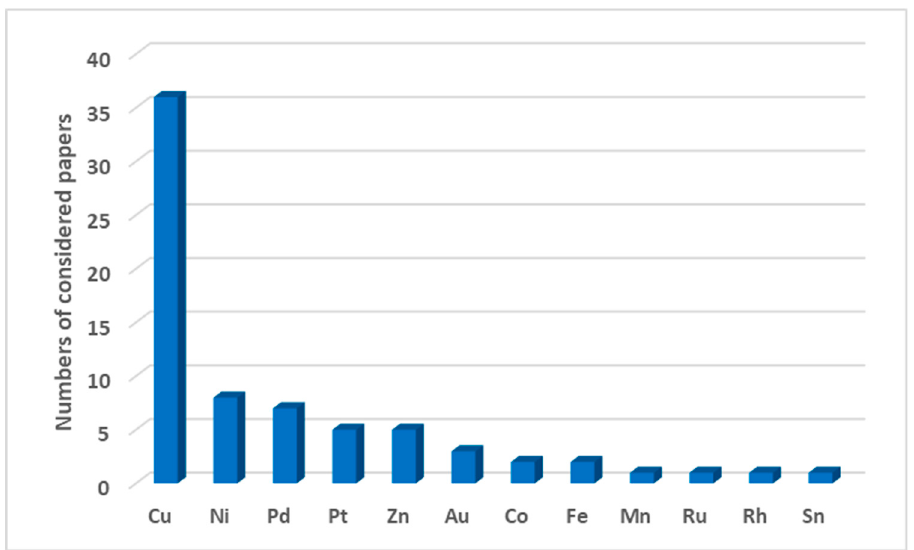
Figure 9. Number of considered papers as a function of the active phase analyzed for the methanol